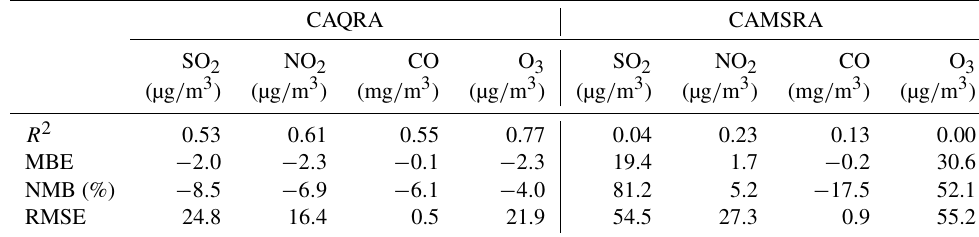
Figure 14. Same as Fig. 7 but for the O 3 concentration. Table 7. Comparison of the data accuracy of CAQRA and CAMSRA in China on an hourly